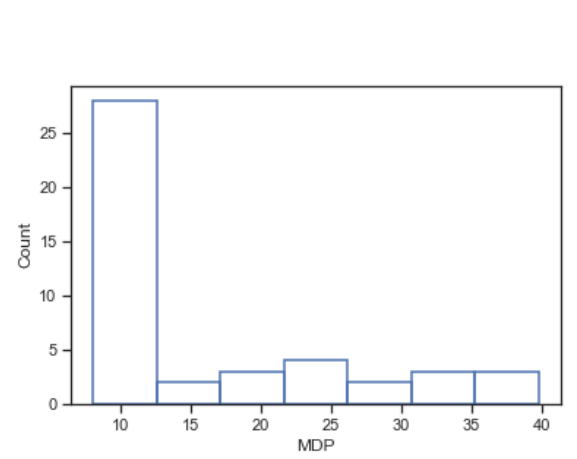
Figure 1. Histogram mobile device proficiency for all 45 participants. Minimum score of 8 corresponds with ‘never tried’ anything on a mobile device, the maximum score of 40 corresponds device.